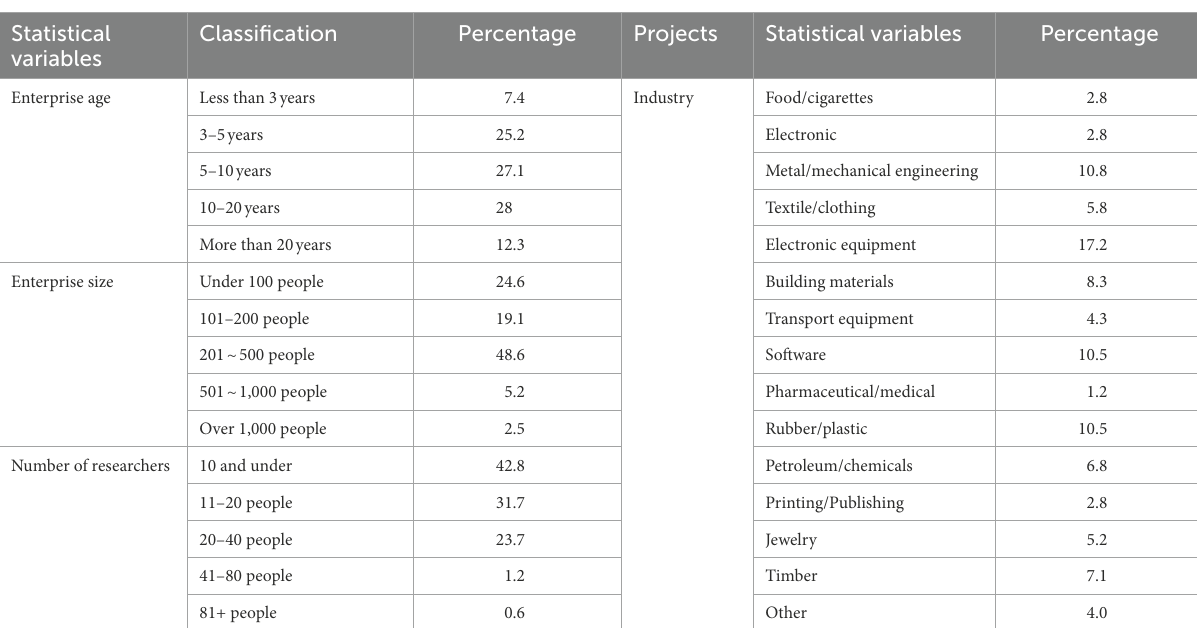
TABLE 1 Characteristics of the sample.